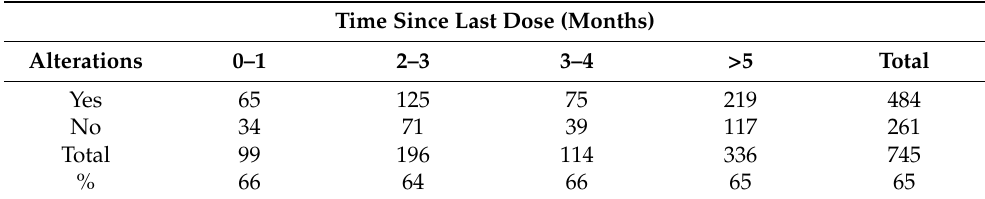
Table 1. Frequency and percentage of woman that reported alterations by time since last dose. Time Since Last Dose